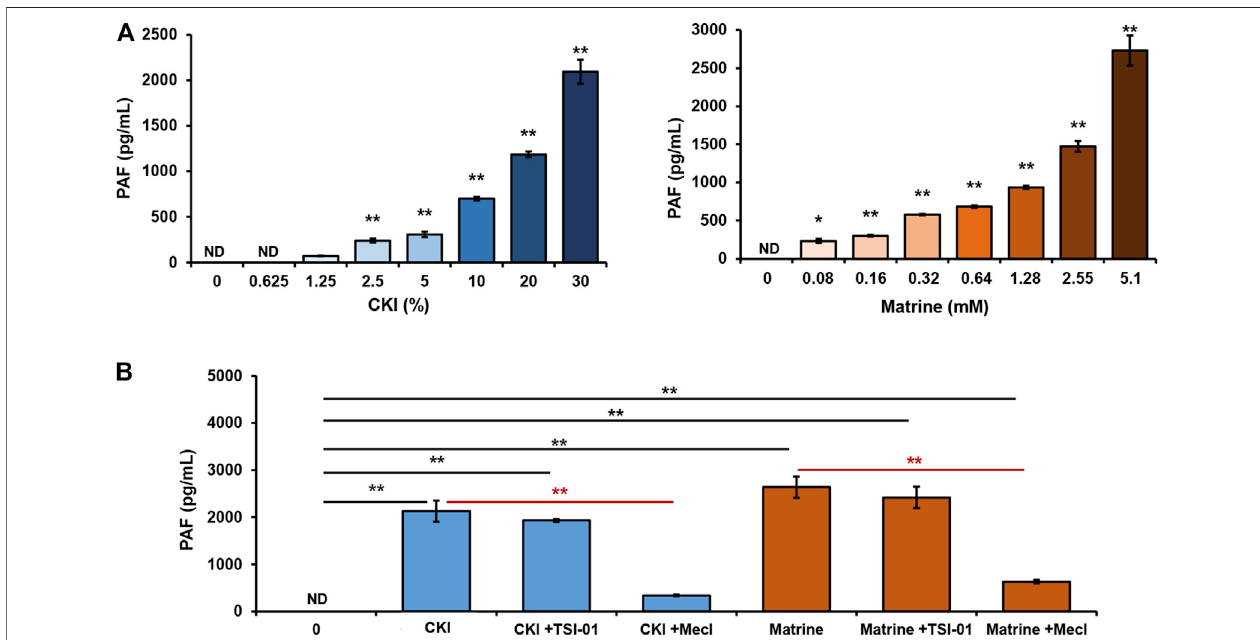
FIGURE 8 | CKI or matrine promotes PAF production via de novo pathway. (A) Effect ofCKI or matrine on PAF production in RBL-2H3 cell lysates. RBL-2H3 cells werelysedonicebyultrasonicationandtheobtainedcelllysateswerecentrifuged(5,000 × g)at4 ° Cfor5 min.Thesupernatant(85 μ gprotein)wasincubatedwithCKIor matrine at 37 ° C for 1 h and then was centrifuged (1,000 × g) at 4 ° C for 20 min. PAF levels in the supernatant were assayed by using commercial PAF ELISA kit. PAF concentration wascalculated according tothe standard curve.* p < 0.05and ** p < 0.01 vs 0 group. (B) Mecl was ableto counteract theeffectsofCKI and matrine on PAF production. RBL-2H3 cell lysates were incubated with CKI or matrine at 37 ° C for 1 h in the presence or absence of blocker (5 μ M of TSI-01 or 20 μ M of Mecl). Then PAF levels were assayed. ** p < 0.01. CKI, Compound Kushen Injection; Mecl, meclofenoxate; ND, not detected.